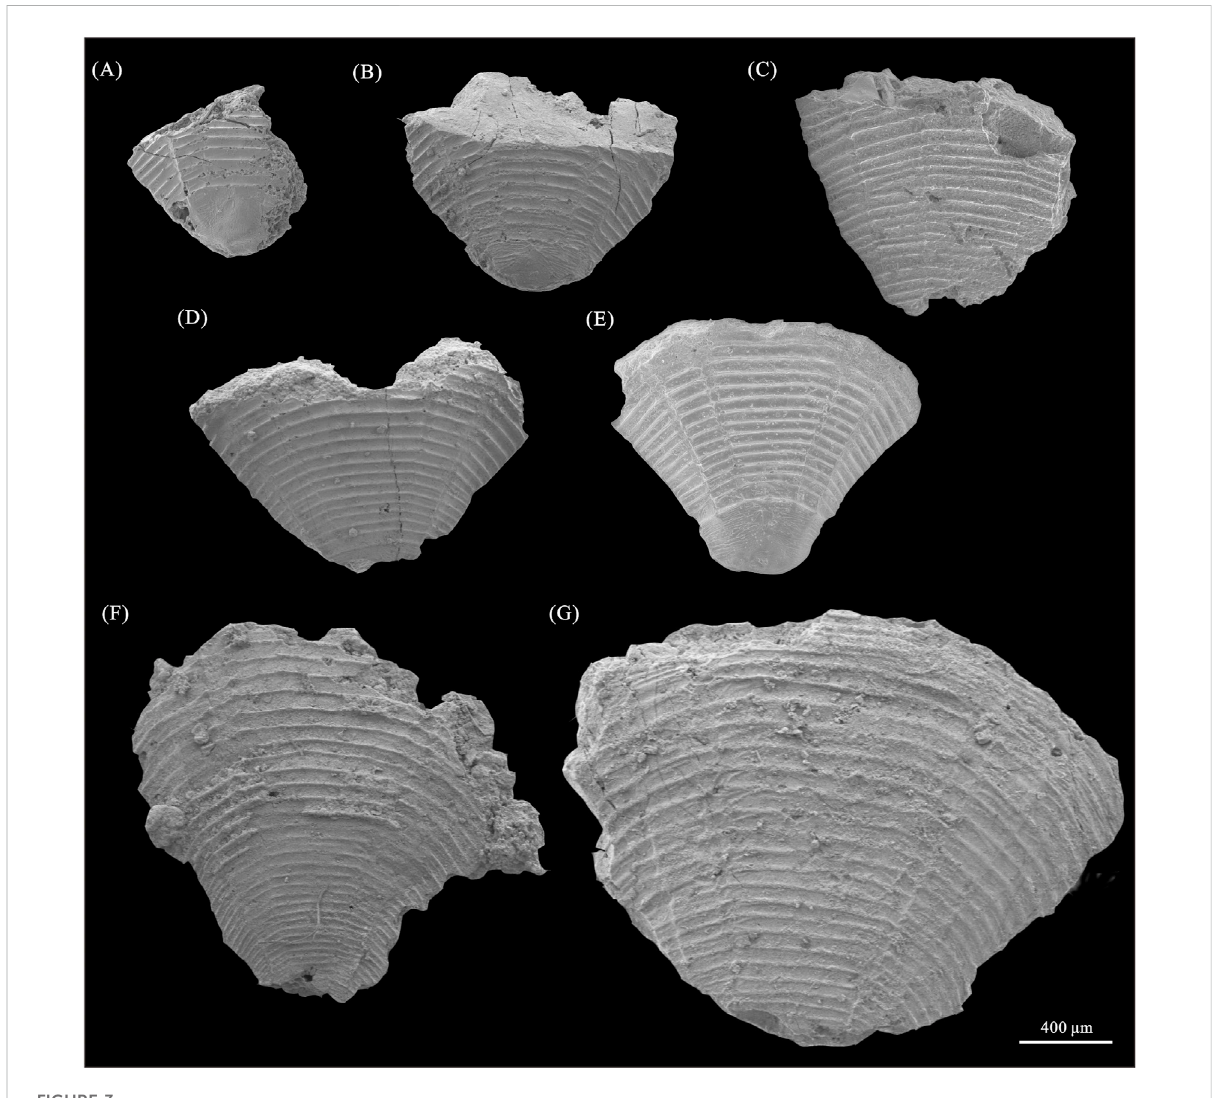
FIGURE 3 Possiblegrowth seriesof Decimoconulariaanisfacialis n.sp.fromtheKuanchuanpuFormation (CambrianFortunianStage)ofsouthernShaanxi Province, China. (A – G) SN096-K44-295, KP-45-3, SN023-K30-131, KP-45-5, SN096-k44-131 (taken from Han et al., 2020, Figure 2C ), KP-45-4, and